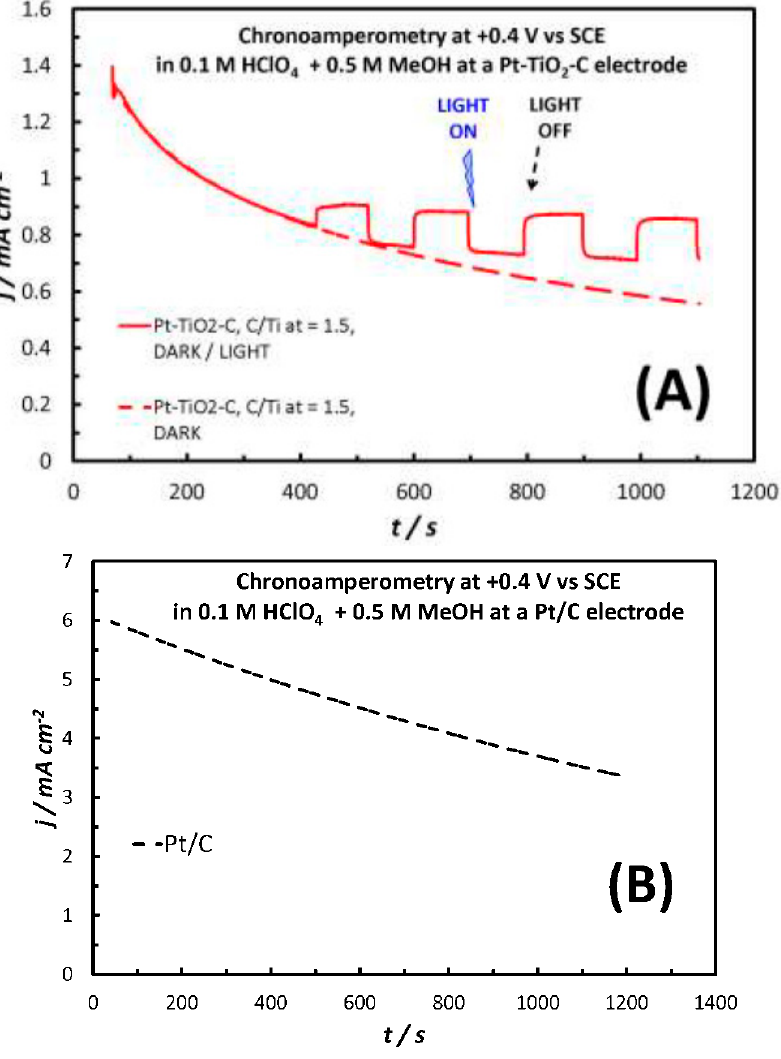
Figure 6. Constant potential chronoamperometry (CA), recorded in 0.1 M HClO 4 + 0.5 M MeOH solutions at + 0.4 V vs. SCE, at a Pt-TiO 2 -C catalyst electrode with a C ÷ Ti atom ratio of 1.5, in the dark and under UV light illumination ( A ) CA recorded at a Pt / C (10% Pt w / w) electrode ( B ) Current densities, j, are per cm 2 of electrode substrate.